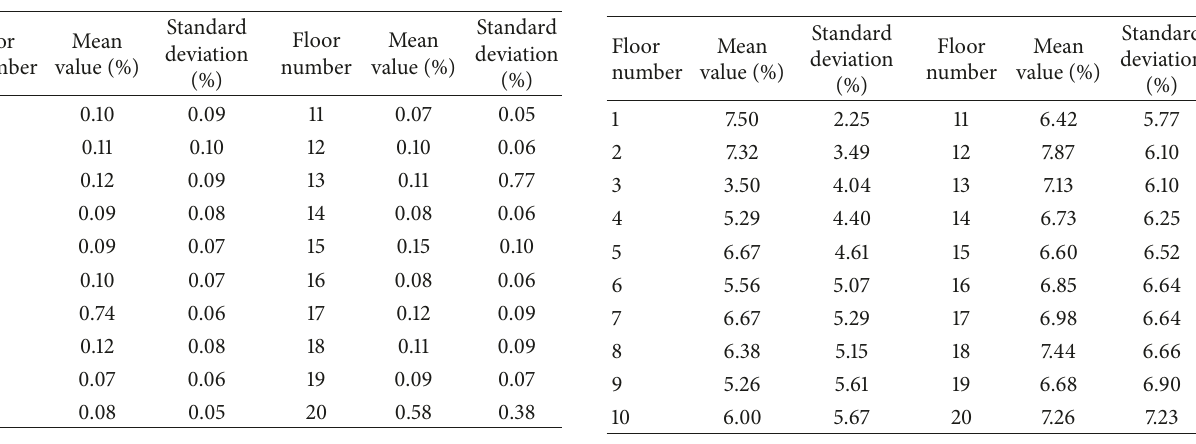
Table 1: The mean value and standard deviation of errors for wind load identification.